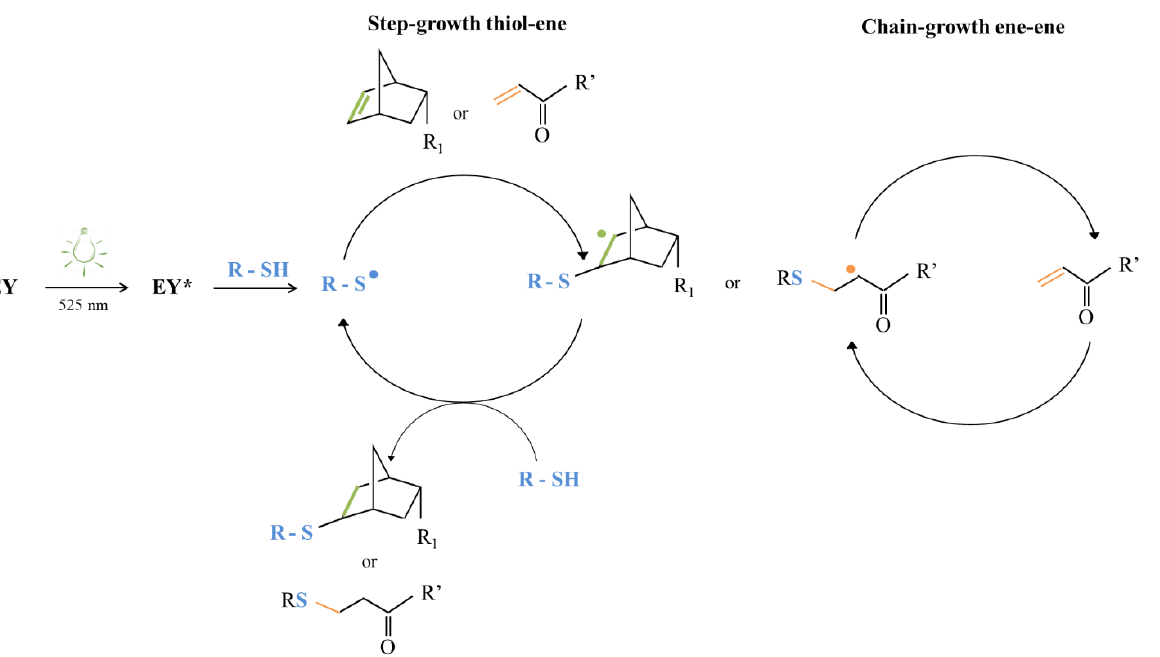
Figure 13. Schematic representation of the photo-crosslinking mechanism occurring based on the -ene moiety: purely step-growth photo-polymerization in the case of thiol-norbornene formulations and a mix mode, i.e., step-growth and chain-growth, in the case of thiol-acrylate systems.